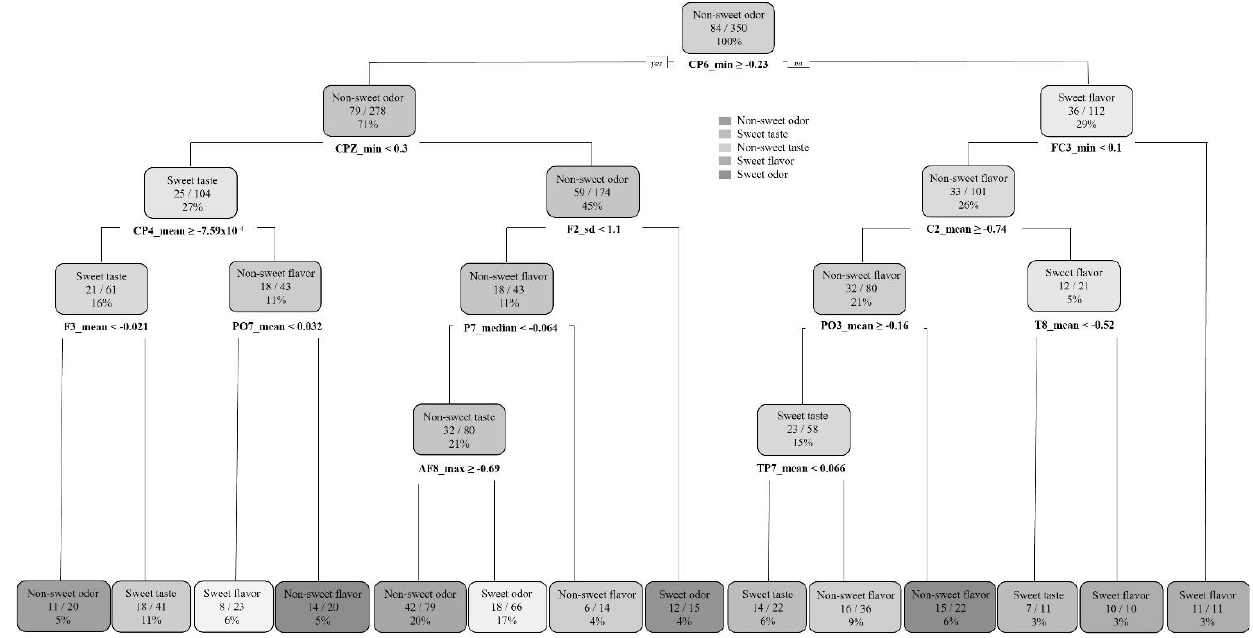
Figure 4. Decision tree of odor, taste, and flavor samples’ discrimination task.